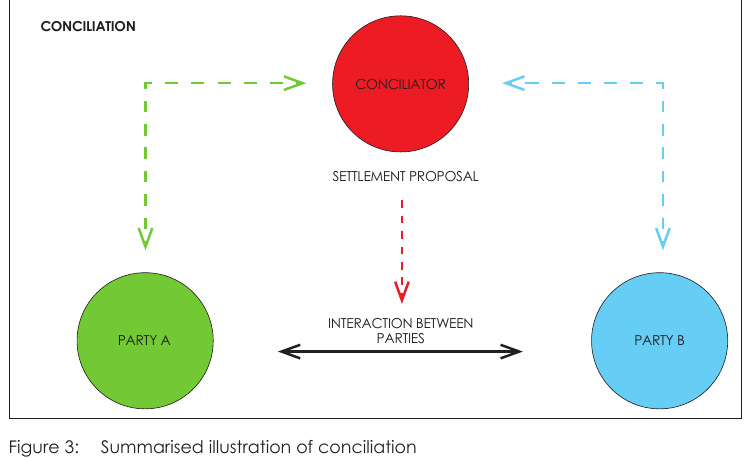
Figure 3: Summarised illustration of conciliation Source: Wilcocks, 2017: